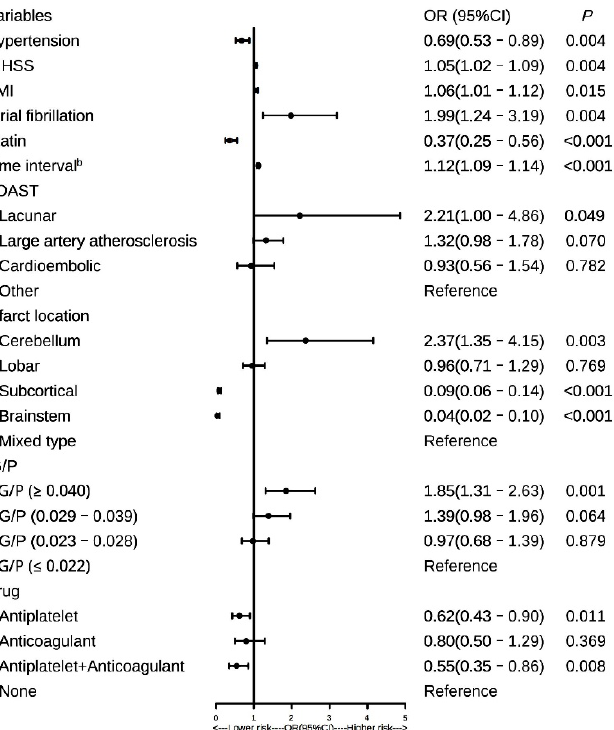
Figure 4. Forest plot of the relationship between variables and the HT risk in patients with AIS. G/P, glucose to platelet ratio; HT, hemorrhagic transformation; AIS, acute ischemic stroke; BMI, body mass index; AF, atrial fibrillation; NIHSS, National Institutes of Health Stroke Scale; Time interval b , time from stroke onset to follow-up scans; TOAST, the trial of ORG 10,172 in acute stroke treatment; OR, odds ratio.